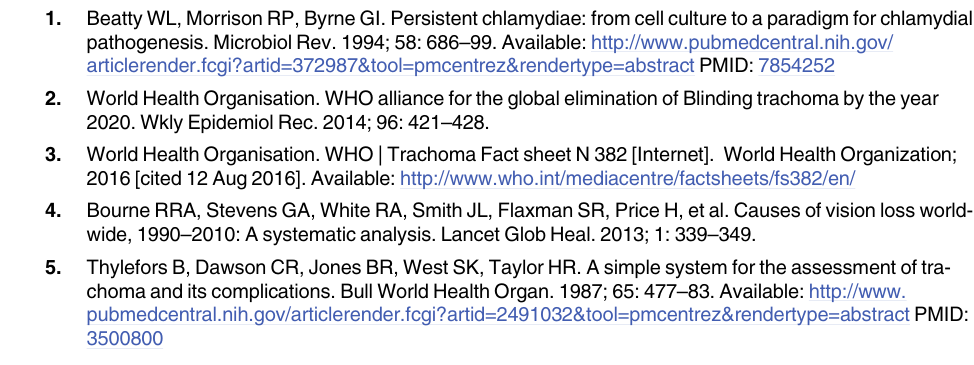
S4 Table. Seroprevalence for Laos by Gender, Region and Age, for each of six thresholds. S5 Table. Seroprevalence for Uganda by Gender, Region and Age, for each of six thresh- olds. S6 Table. Seroprevalence for The Gambia by Gender, Region and Age, for each of six